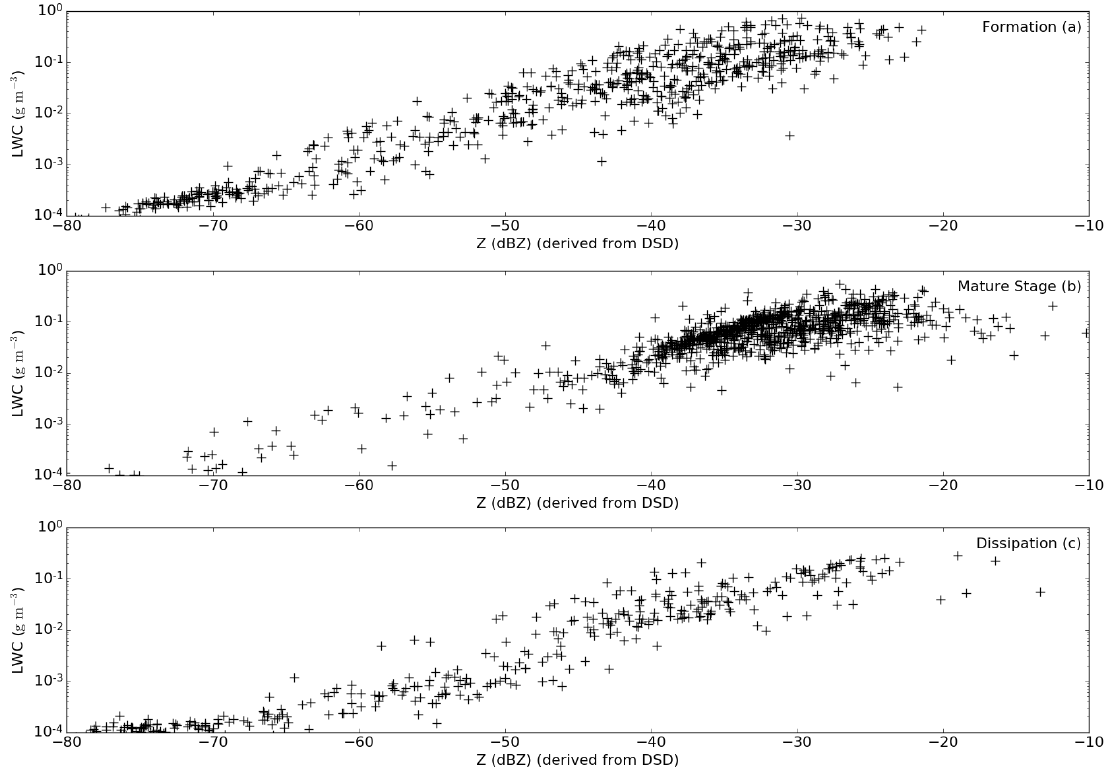
Figure 11. Derived LWC vs. derived Z for all three fog events in ( a ) Formation, ( b ) Mature stage and ( c ) Dissipation.